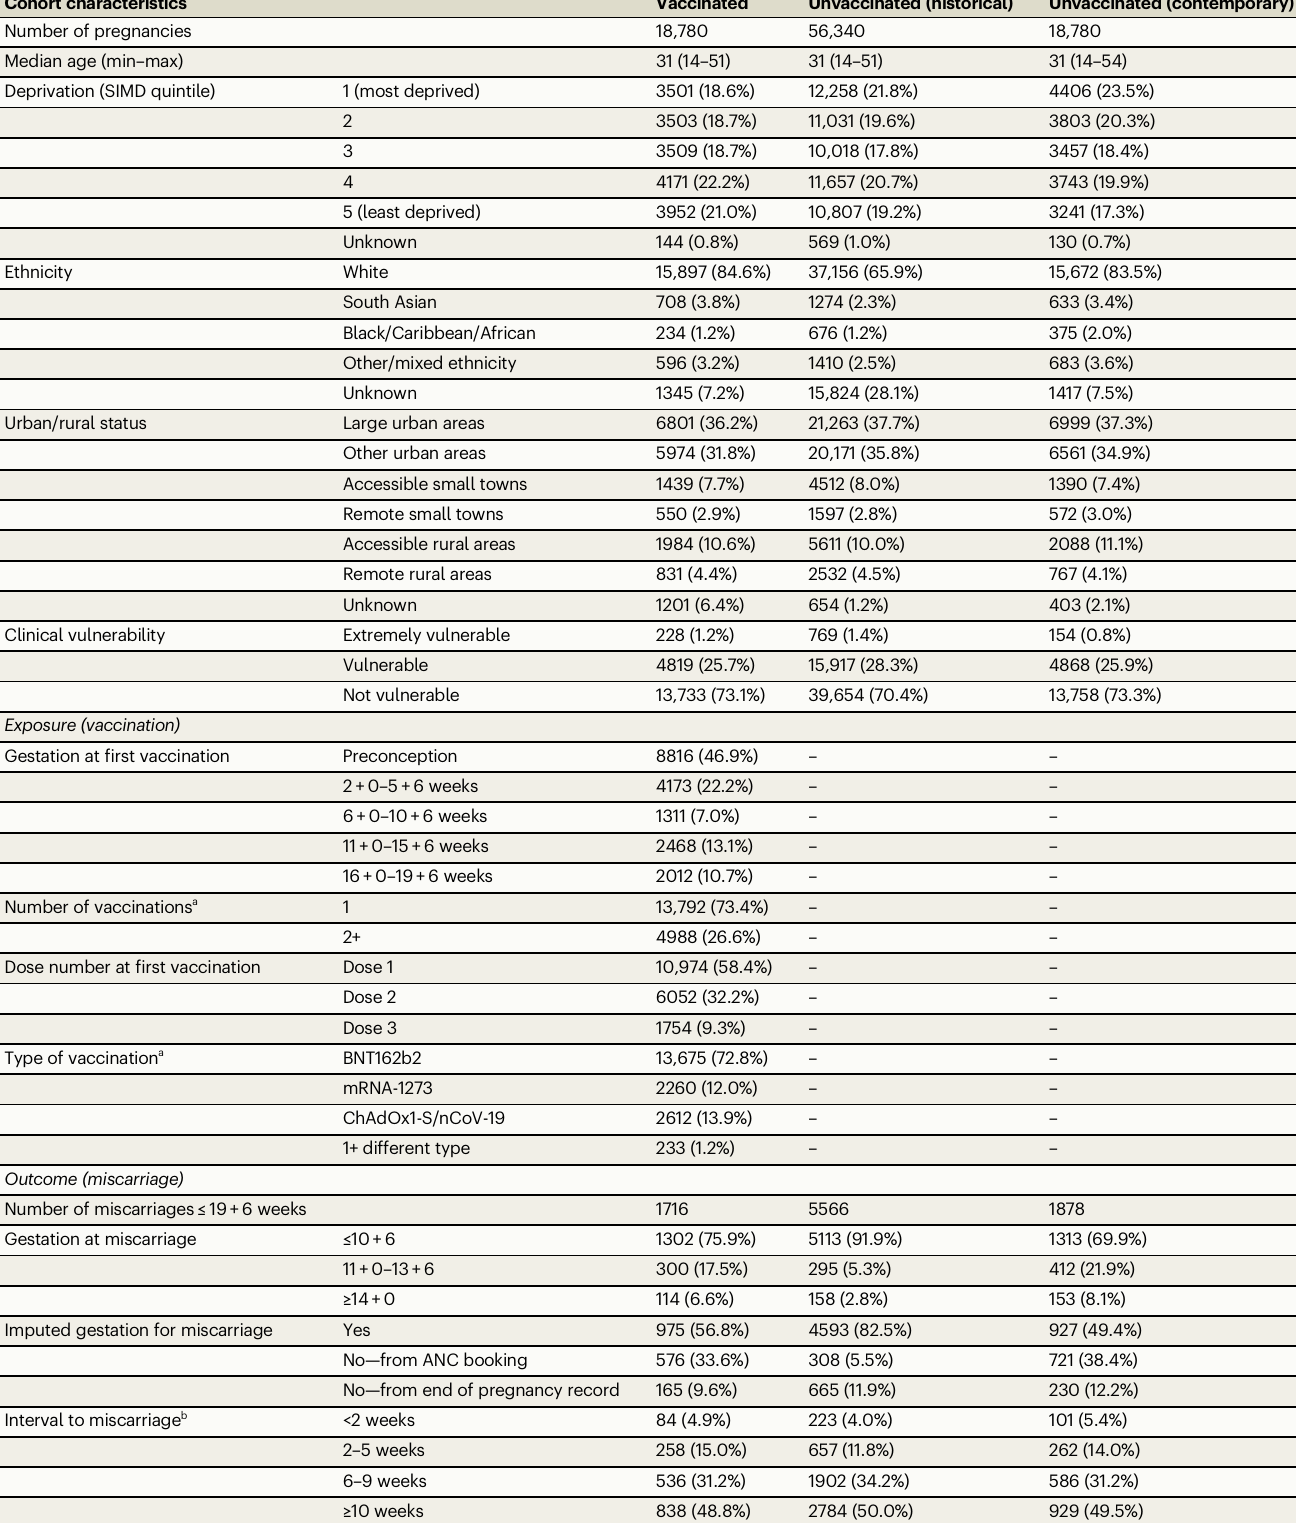
Table 1 | Key characteristics of vaccinated and control groups included in the vaccination and miscarriage